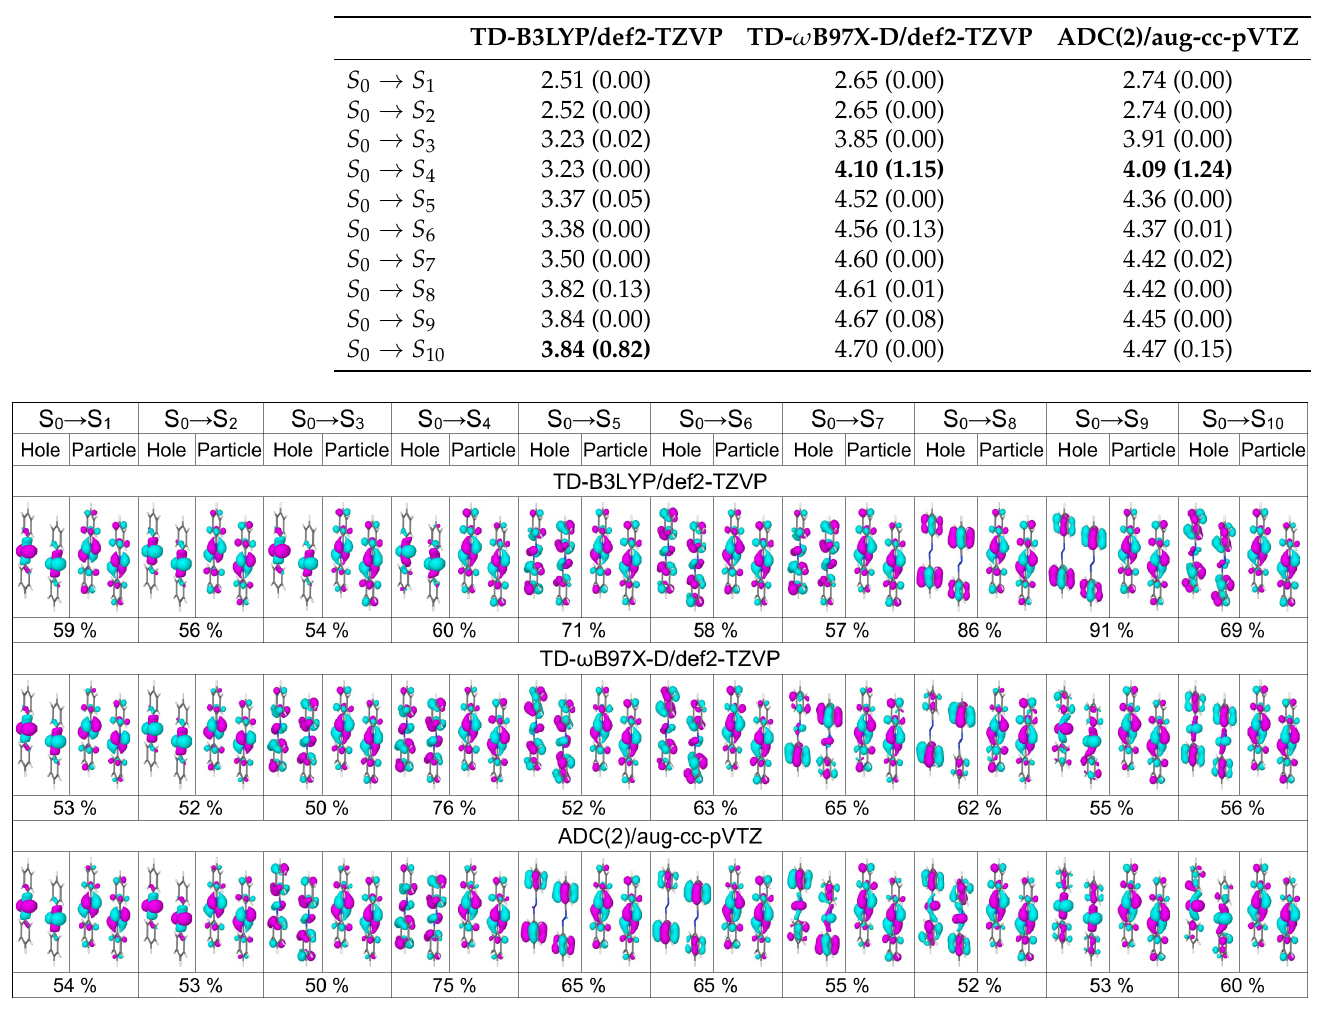
Table 4. Vertical excitation energies in eV and oscillator strengths (in parentheses) of the lowest ten electronic transitions of the optimized B3LYP+D3/def2-TZVP dimer calculated with TD-B3LYP/def2-